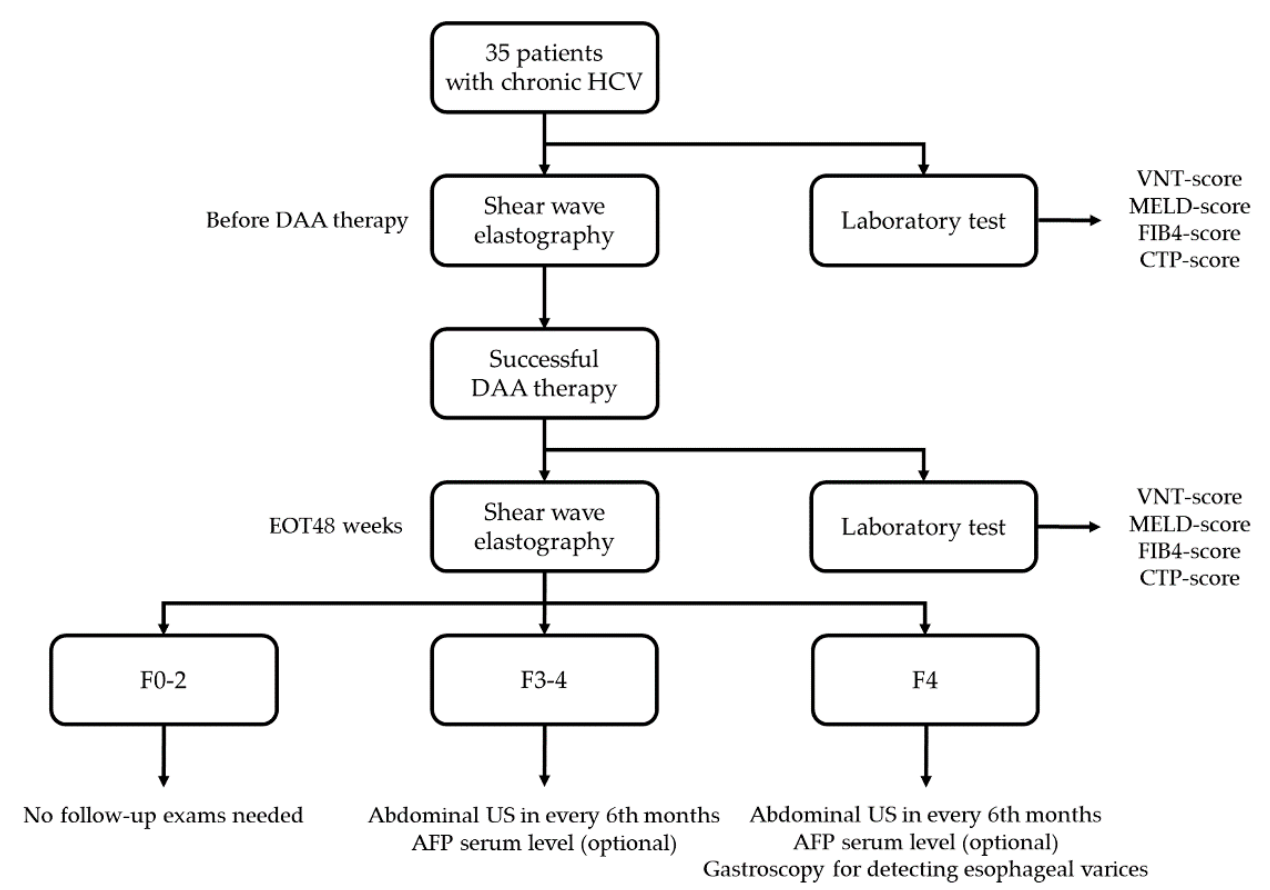
Figure 3. The flowchart shows the design of our prospective study. We prospectively enrolled 35 patients who were diagnosed with chronic hepatitis C virus infection and who attained sustained virological response after treatment with DAA agents or interferon-based treatment. The METAVIR score of liver fibrosis was determined for each patient both before and after the antiviral treatment based on the result of the shear wave elastography measurement. The FIB4 score, the number of patients with varices needing treatment, the Child-Turcotte-Pugh class, and the MELD-score were calculated from laboratory tests as it was described previously [17,19–21]. HCV: hepatitis C virus; DAA: direct-acting antiviral therapy; EOT48w: 48 weeks after successful antiviral treatment; VNT: varices needing treatment; MELD: model for end-stage liver disease; FIB4-score: fibrosis-4 score; CTP: Child-Turcotte-Pugh; AFP: alpha-fetoprotein; US: